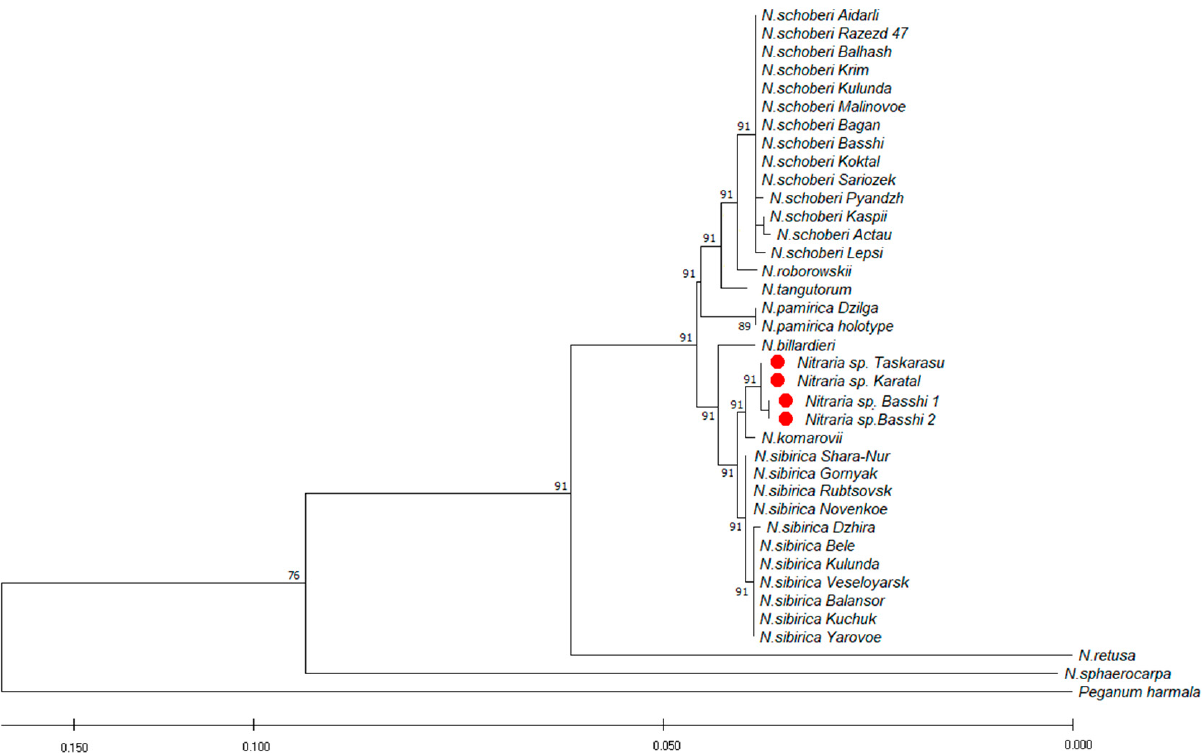
Figure 4. Phylogenetic tree inferred from the combined ITS and cpDNA data using the ML method. The number near branches are bootstrap values (BS > 50%). Red symbols— N. iliensis .